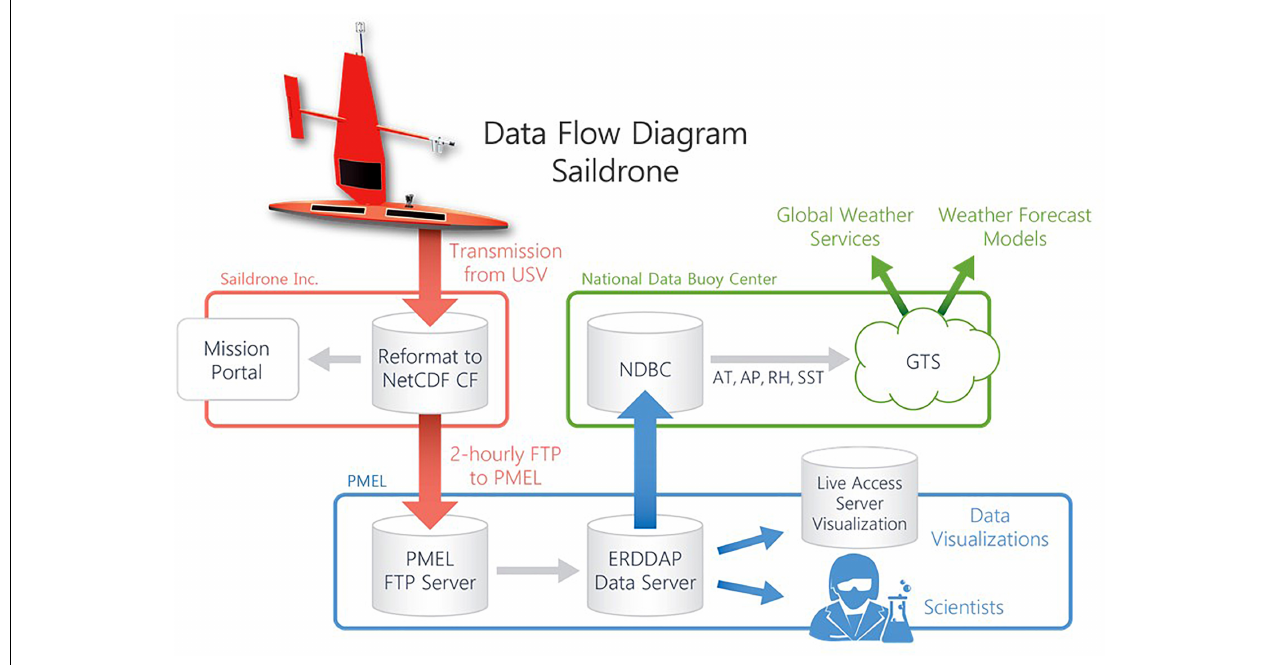
FIGURE 6 | Near real-time data workflow between Saildrone Inc., PMEL, and operational data dissemination network